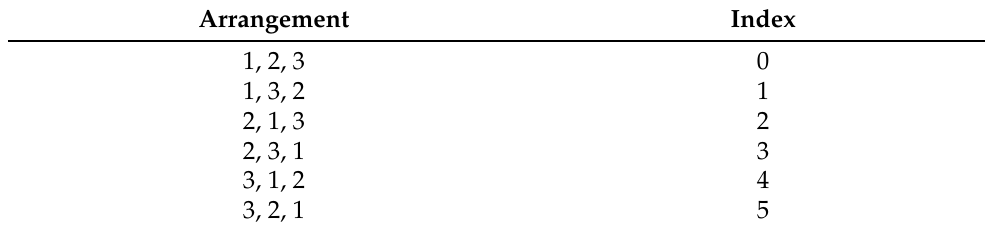
Table 1. Index table.